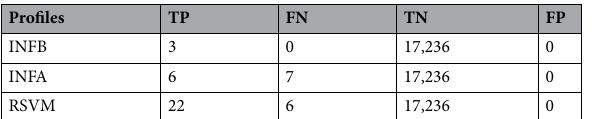
Table 2. Independent testing of profiles against test and negative datasets. INFA anti-Influenza A virus, INFB anti-Influenza B virus, RSVM anti-Respiratory Syncytial Virus, TP true positive, TN true negative, FP false- positive, FN false-negative.